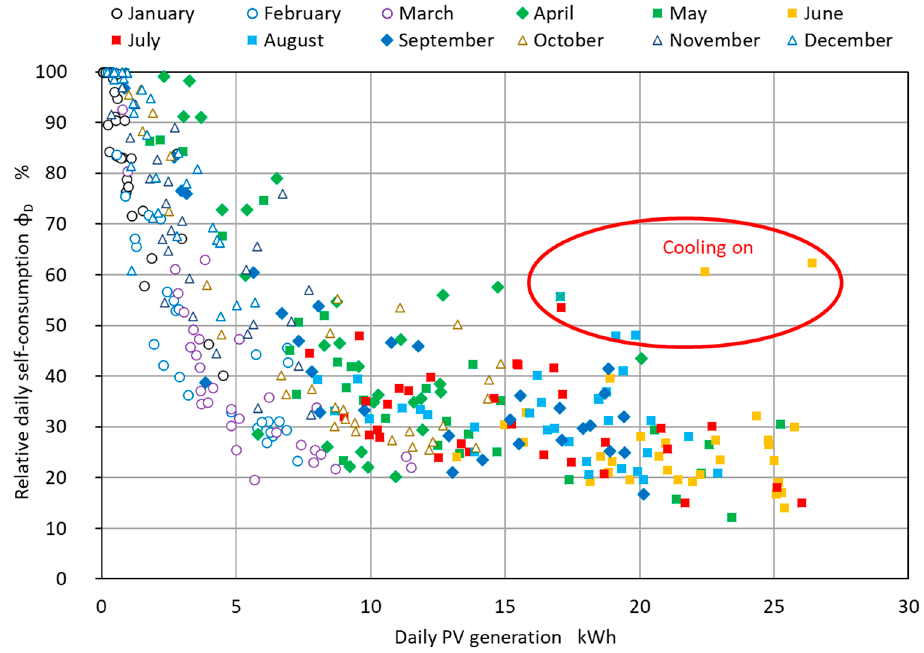
Figure 13. Relative self-consumption as a function of the daily PV generation, indicating the months of the year.